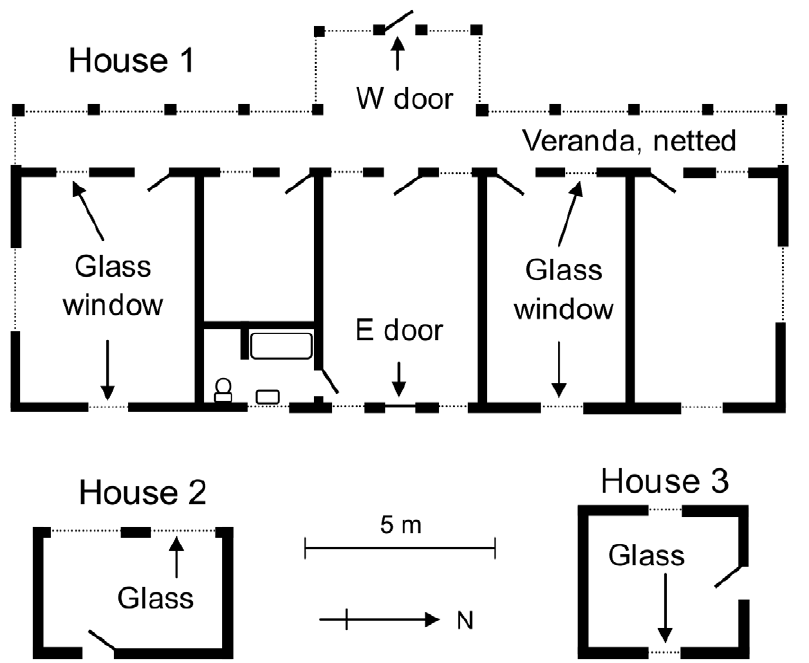
Figure 1. Plan view of Houses 1–3. In House 1 the internal glass windows and internal doors were always open; the external E door was always closed. The external W door of House 1, the external doors of Houses 2 and 3, and the external glass windows of all houses were open or closed as described in the text.